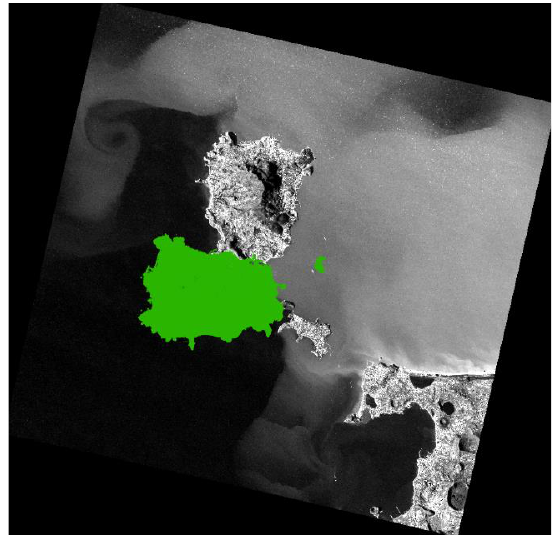
Figure 3. Superimposition between the “orthorectified” image, obtained using a north-correct raw image, and the actual position of the isle of Ischia (in green).